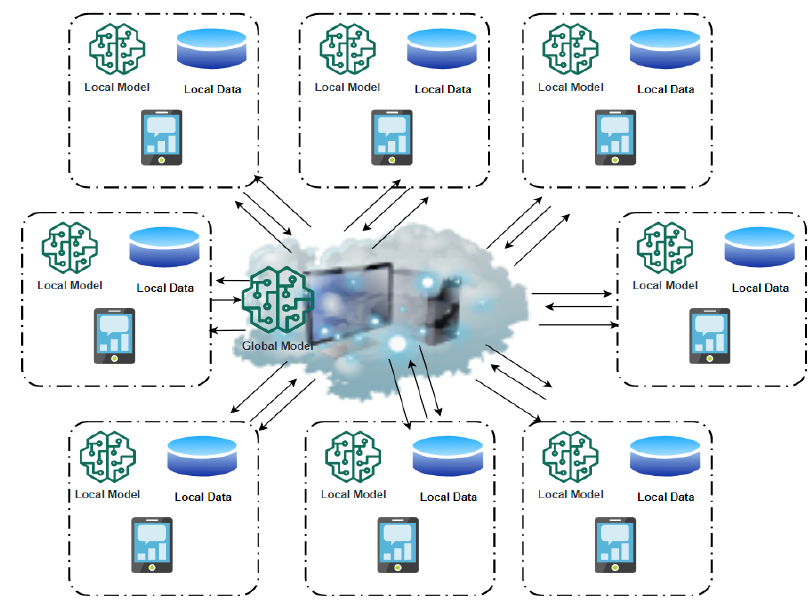
Figure 1. Local vs. global models in FL.